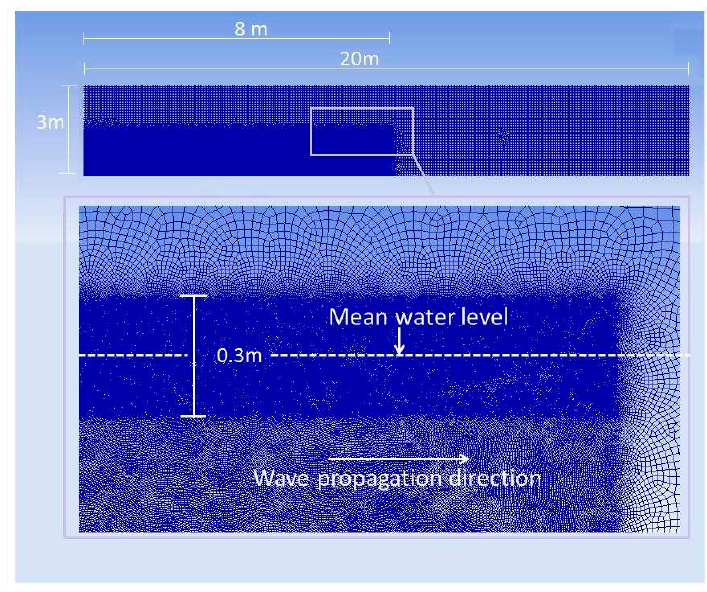
Figure 2. Details of the problem domain ( top ) and mesh re fi nement near the surface ( bottom ). The darker blue represents areas with more re fi ned mesh.